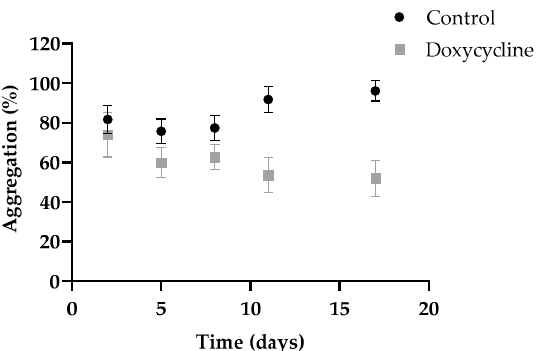
Figure 4. Effect of doxycycline on preformed TTRwt fibrils at pH 4.4 monitored by turbidity. Samples of preformed TTRwt fibrillar species (3.6 µ M) were incubated both in the absence (control) and presence of 50 × molar excess of doxycycline (180 µ M) for the indicated time, at room temperature.